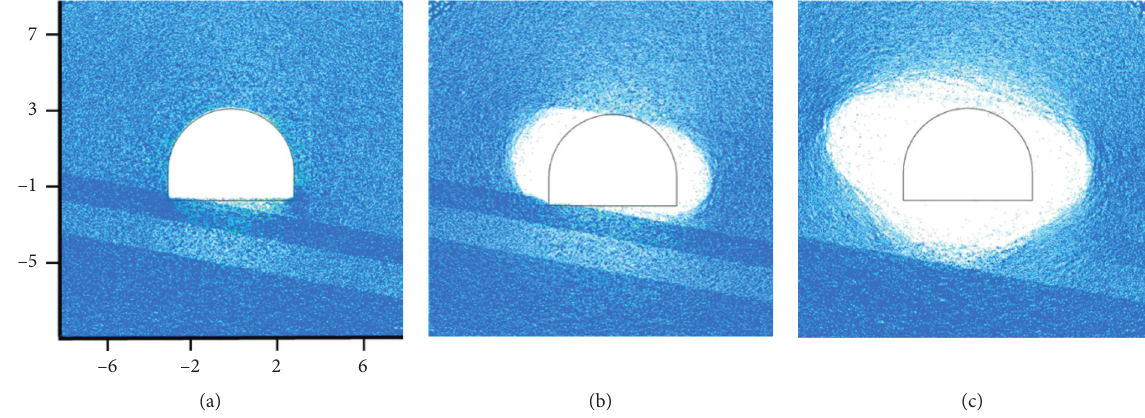
Figure 22: The contact force chain distribution during longwall